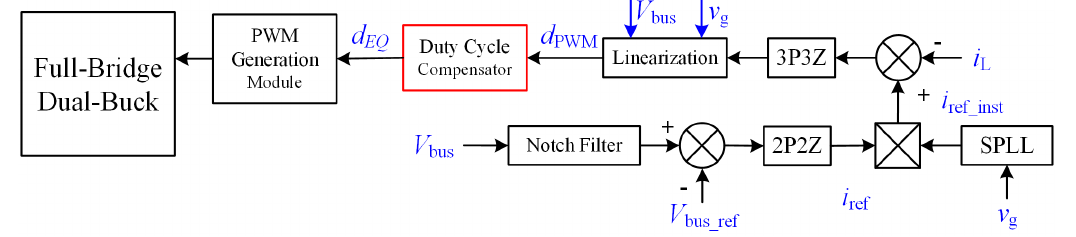
Figure 13. Location of the compensator.